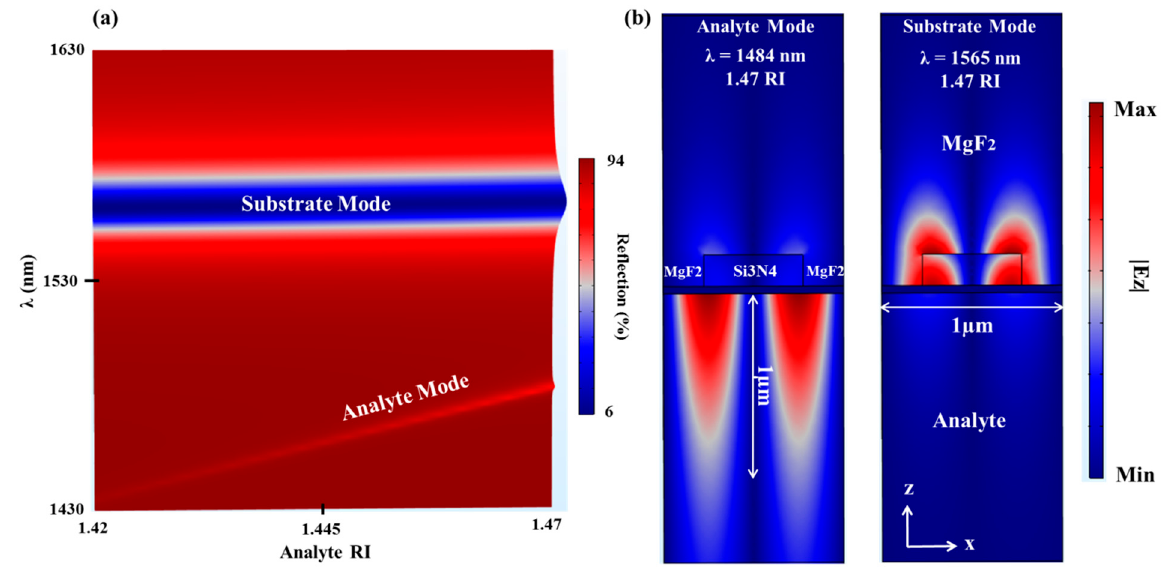
Figure 8. ( a ) Reflection analyte RI– λ map of the TDGTMF geometry for h = 175 nm and d = 40 nm when replacing the analyte medium (ambient or superstrate) with MgF 2 , while the substrate was replaced with a RI close to that of SiO 2 (1.42–1.47 RI), for example, with blood or serum as the medium. ( b ) FD at the resonant wavelengths in Figure 8a at 1.47 analyte RI. TM-polarized light under normal incidence was used in the simulations of the Si 3 N 4 grating, with Λ = 1000 nm and FF = 0.55.